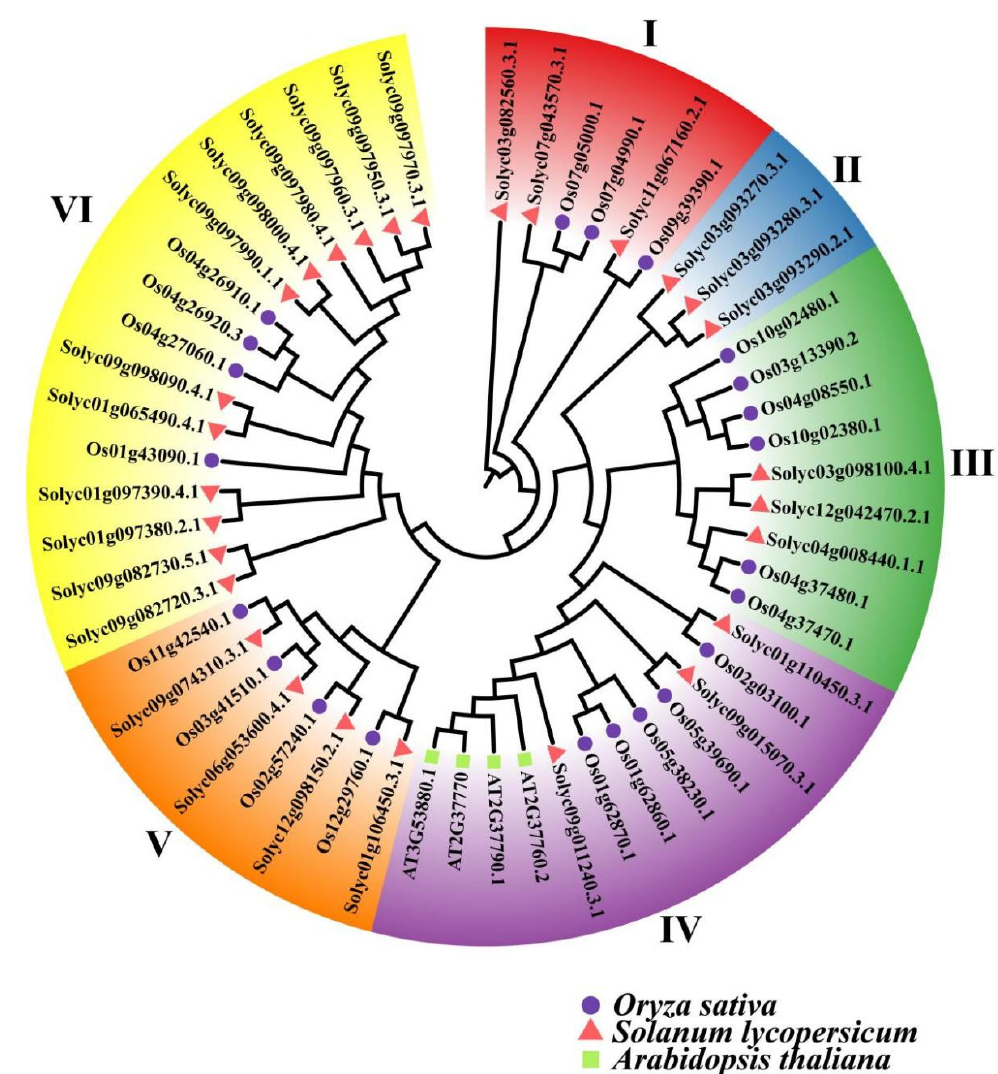
Figure 5. Phylogenic relationship of the AKR protein family in Solanum lycopersicum , Arabidopsis thaliana , and Oryza sativa. Red triangles represent Solanum lycopersicum , green squares represent Arabidopsis thaliana , and purple circles represent Oryza sativa